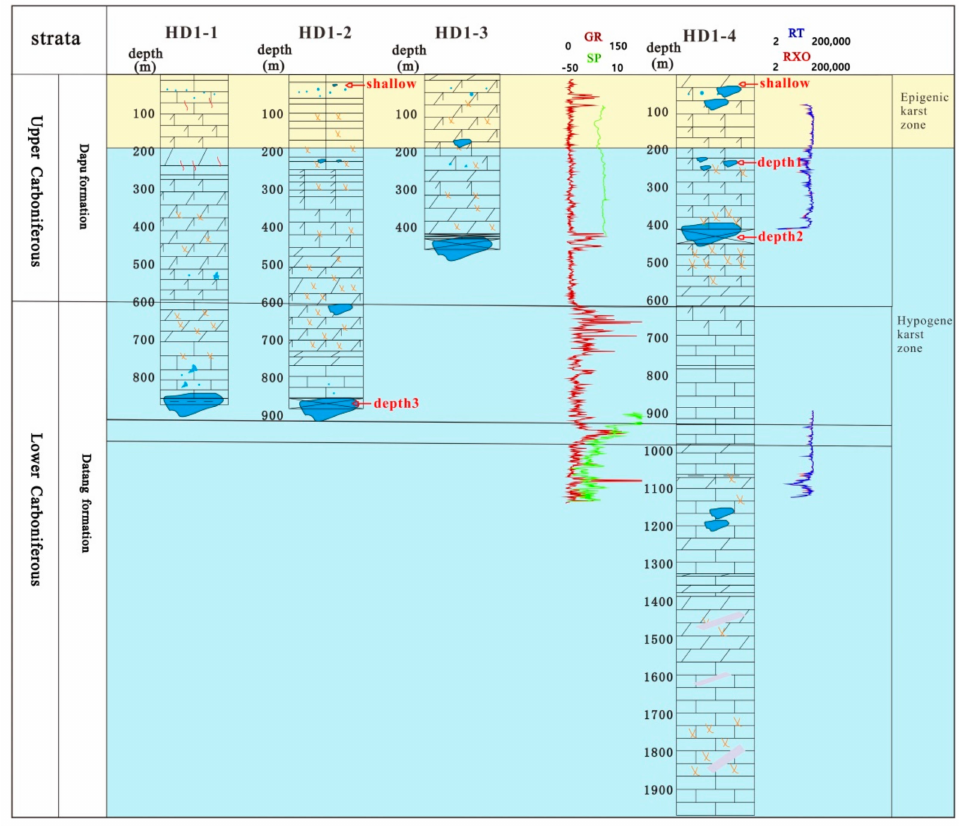
Figure 2. Comparison map of middle and deep karst caves in Huanjiang syncline wells (three karst sections are found in the 230 m, 430 m, and 860 m